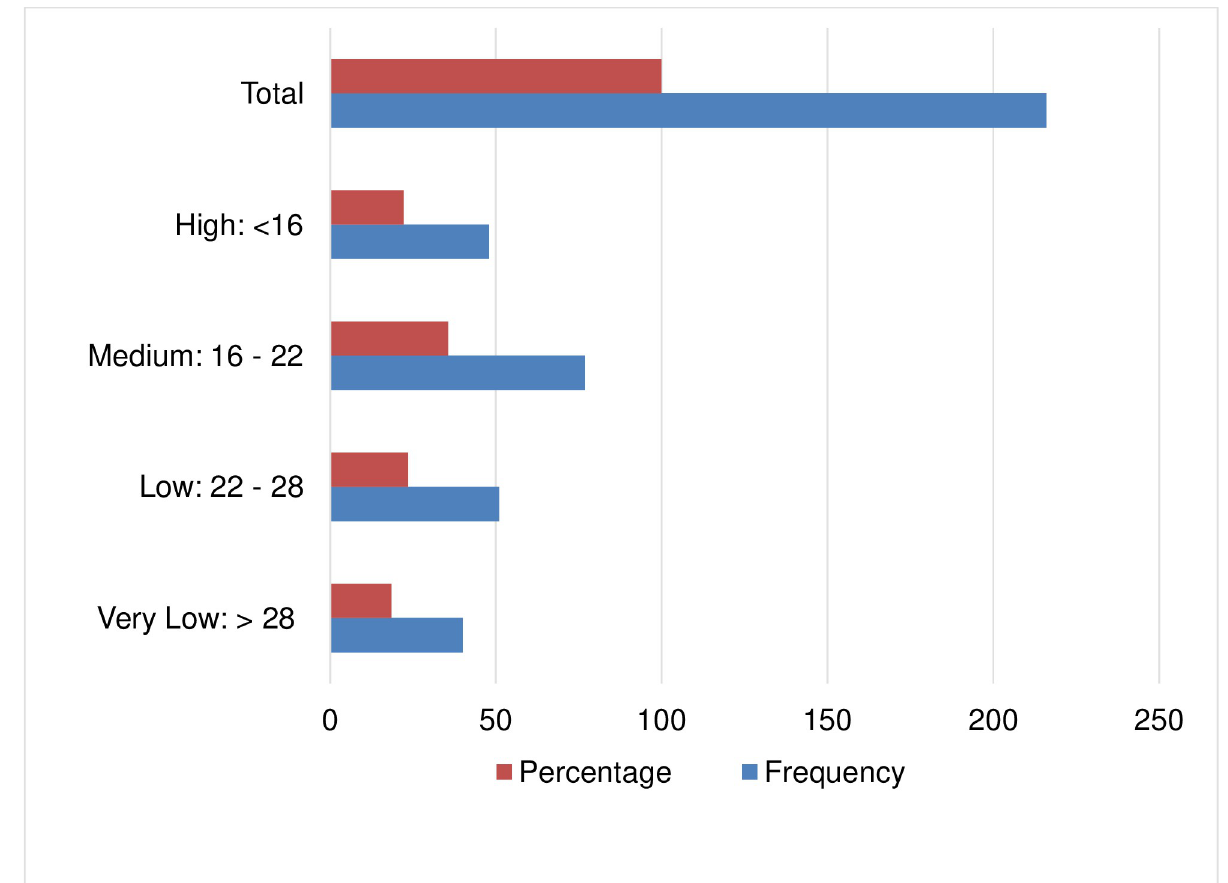
Fig 2. DNA amount and cycle threshold value across the study